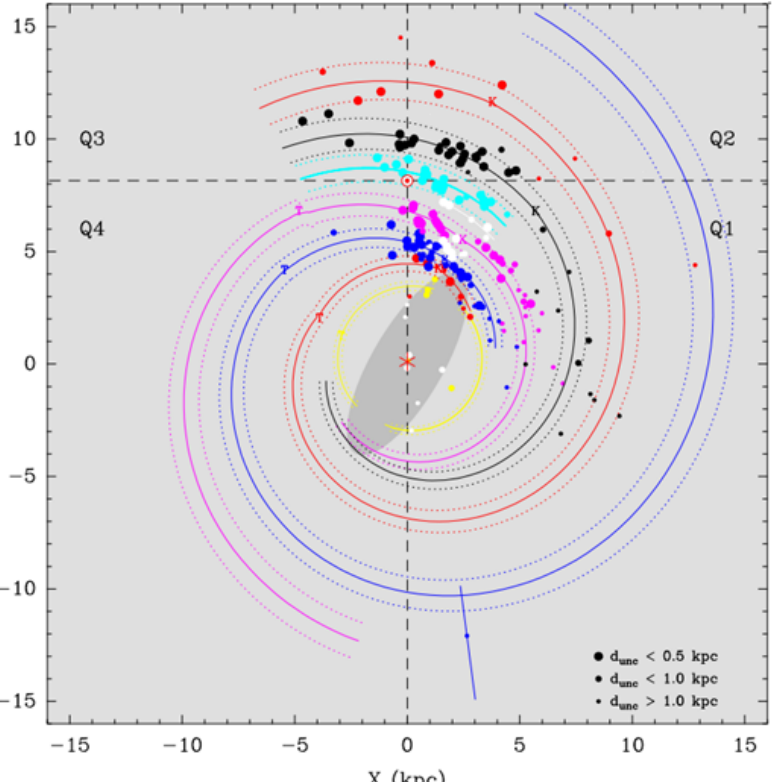
Figure 4. The spiral arms in the Galactic plane, and the maser sources which had their distances measured by VLBI parallax. The Sun is indicated by a red dot. The quadrants of the Galaxy are indicated by Q1, Q2, etc. (taken from Reid et al. 2019). One can see that there are much less VLBI measurements in Quadrant 3, which would require radiotelescopes in the Southern Sky.